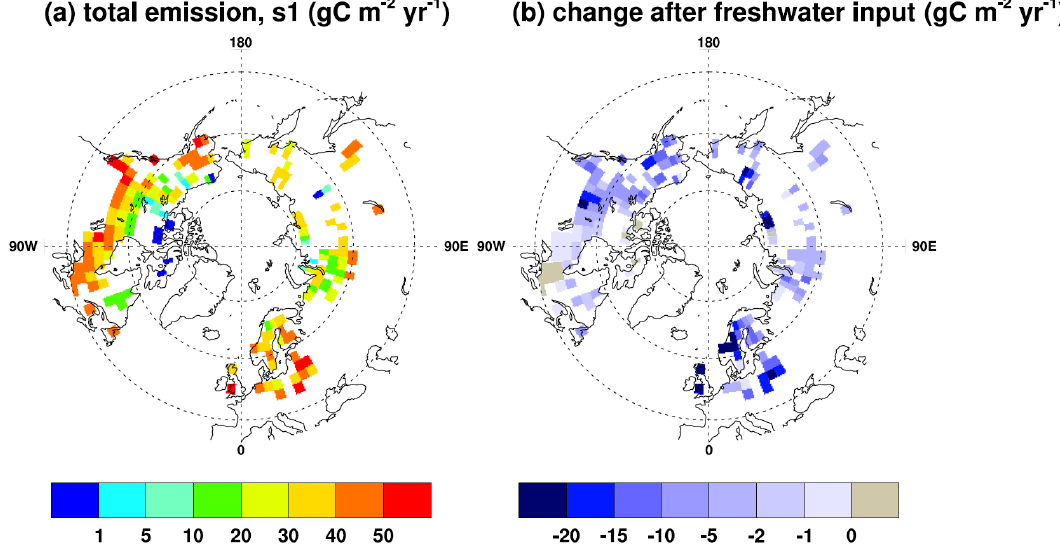
Fig. 7. (a) Spatial distribution of methane emissions (gCm − 2 yr − 1 per wetland area) from the sum of plant-mediated transport, diffusion and ebullition averaged over the first fifty years of the control run. (b) Difference in methane emission (gCm − 2 yr − 1 ) in 50-yr averages of monthly data before and after the freshwater release of ensemble run 1. Note that fluxes per unit area always denote fluxes per wetland area, not grid cell area.